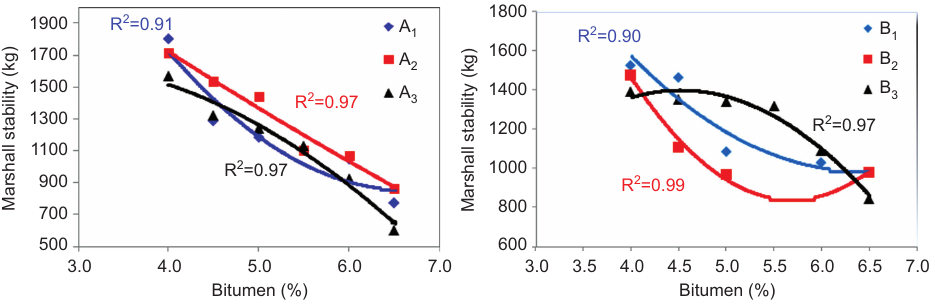
Figure 5 Relation between % bitumen and Marshall stability.